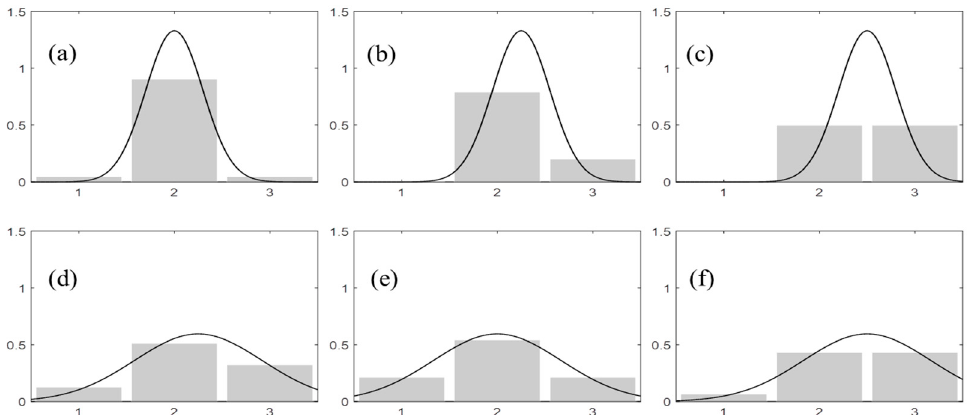
Figure 4. Signal intensity profiles and pixel detected signals under different Gaussian widths σ PSF and centroid positions x 0 (line: signal intensity profile, bar: pixel detected signal in three-pixel window, y axis: relative intensity). ( a ) σ PSF = 0.3, x 0 = 2.0; ( b ) σ PSF = 0.3, x 0 = 2.25; ( c ) σ PSF = 0.3, x 0 = 2.5; ( d ) σ PSF = 0.671, x 0 = 2.0; ( e ) σ PSF = 0.671, x 0 = 2.25; ( f ) σ PSF = 0.671, x 0 = 2.5.